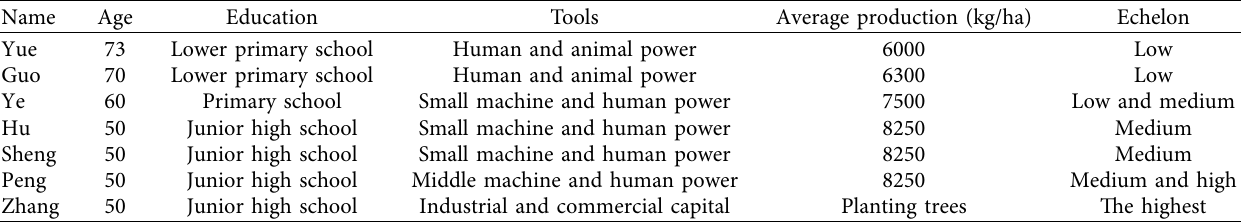
Table 1: The production capacity echelon in village G.